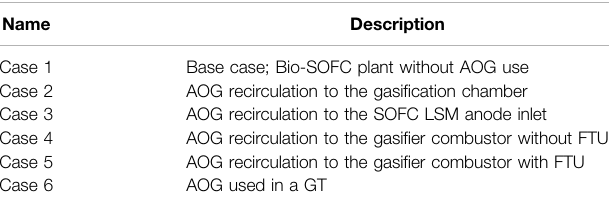
TABLE 3 | Cases analyzed in Scenario Evaluation . Pressurized gasi fi er, not fi xed HEN, global FU (cid:1) 0.75, and, when present, VL separation at 20 ° C (see the corresponding Supplementary Figures S1 – S6